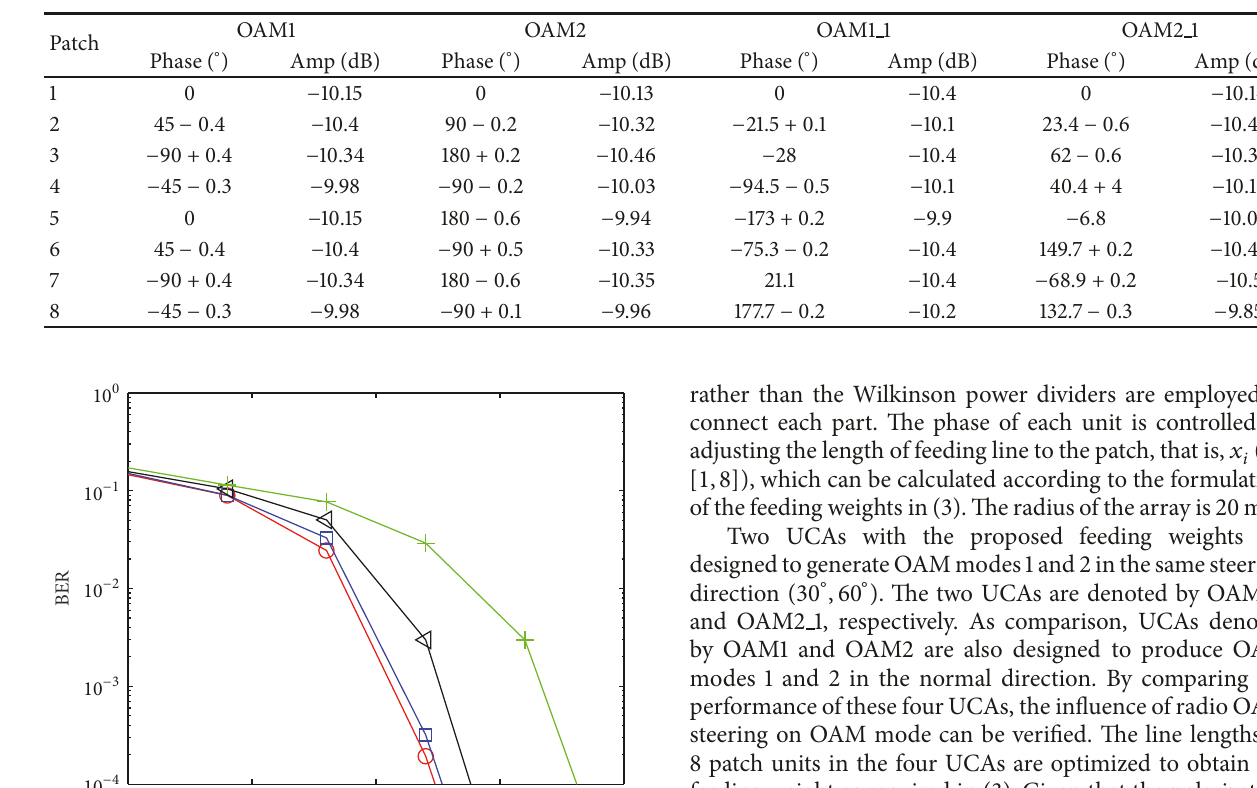
Table 1: The feeding phases and amplitudes of each patch for different antenna arrays.